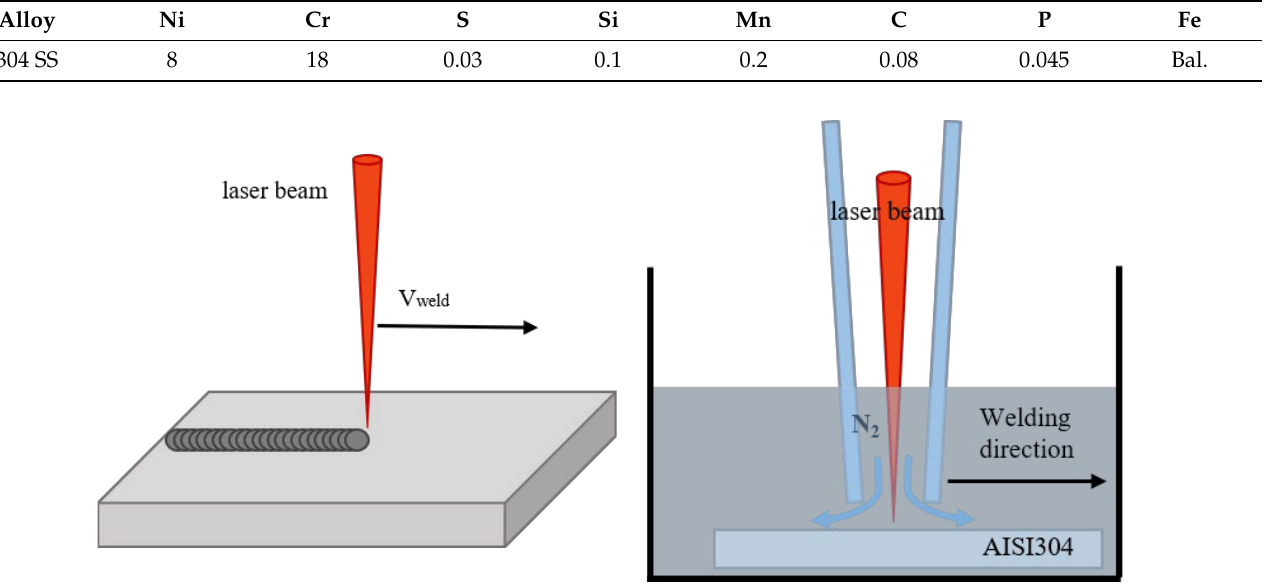
Figure 1. Schematic illustrations of local dry underwater laser welding process. Table 1. Chemical composition of 304 stainless steel specimens (wt.%).